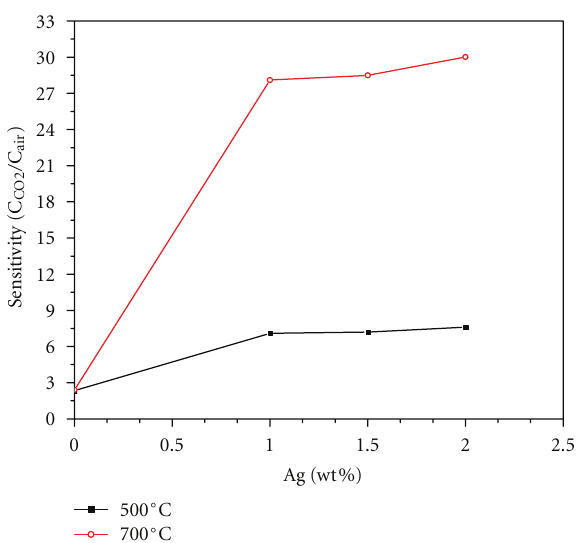
Figure 9: Variation of the sensitivity to CO 2 gas of BaTiO 3 -CuO sensors with Ag content at di ff erent sintering